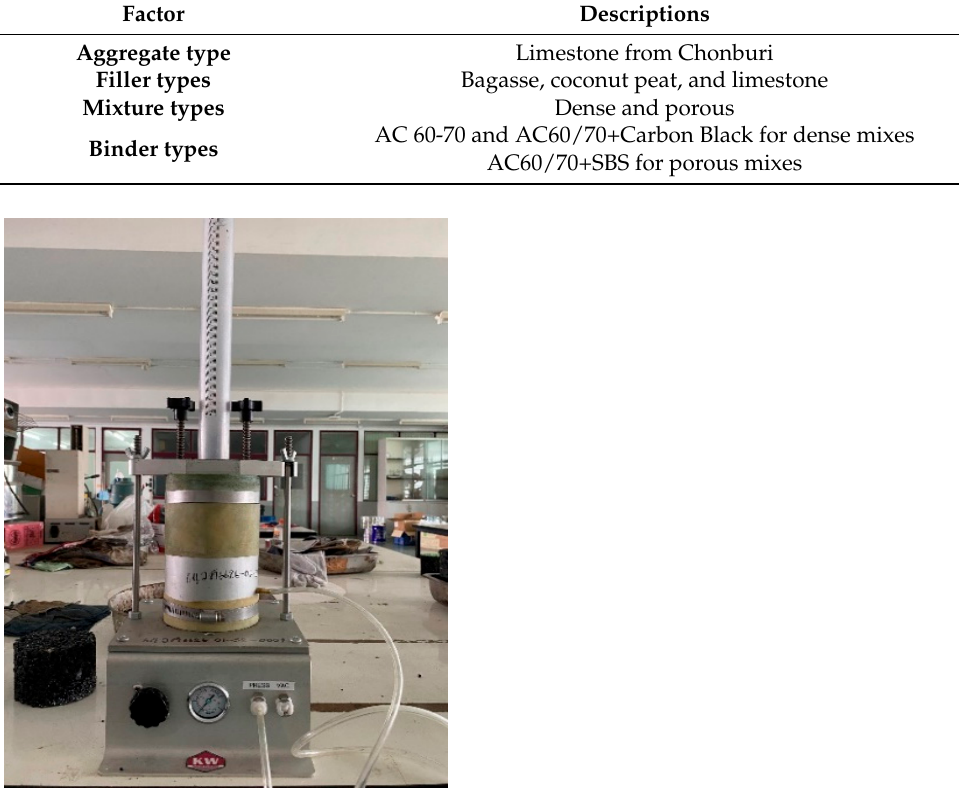
Figure 2. Florida permeability tester.